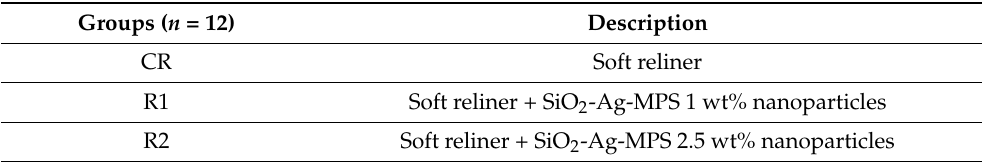
Table 2. Division of experimental groups according to the concentration of SiO 2 -Ag-MPS nanoparti- cles for the